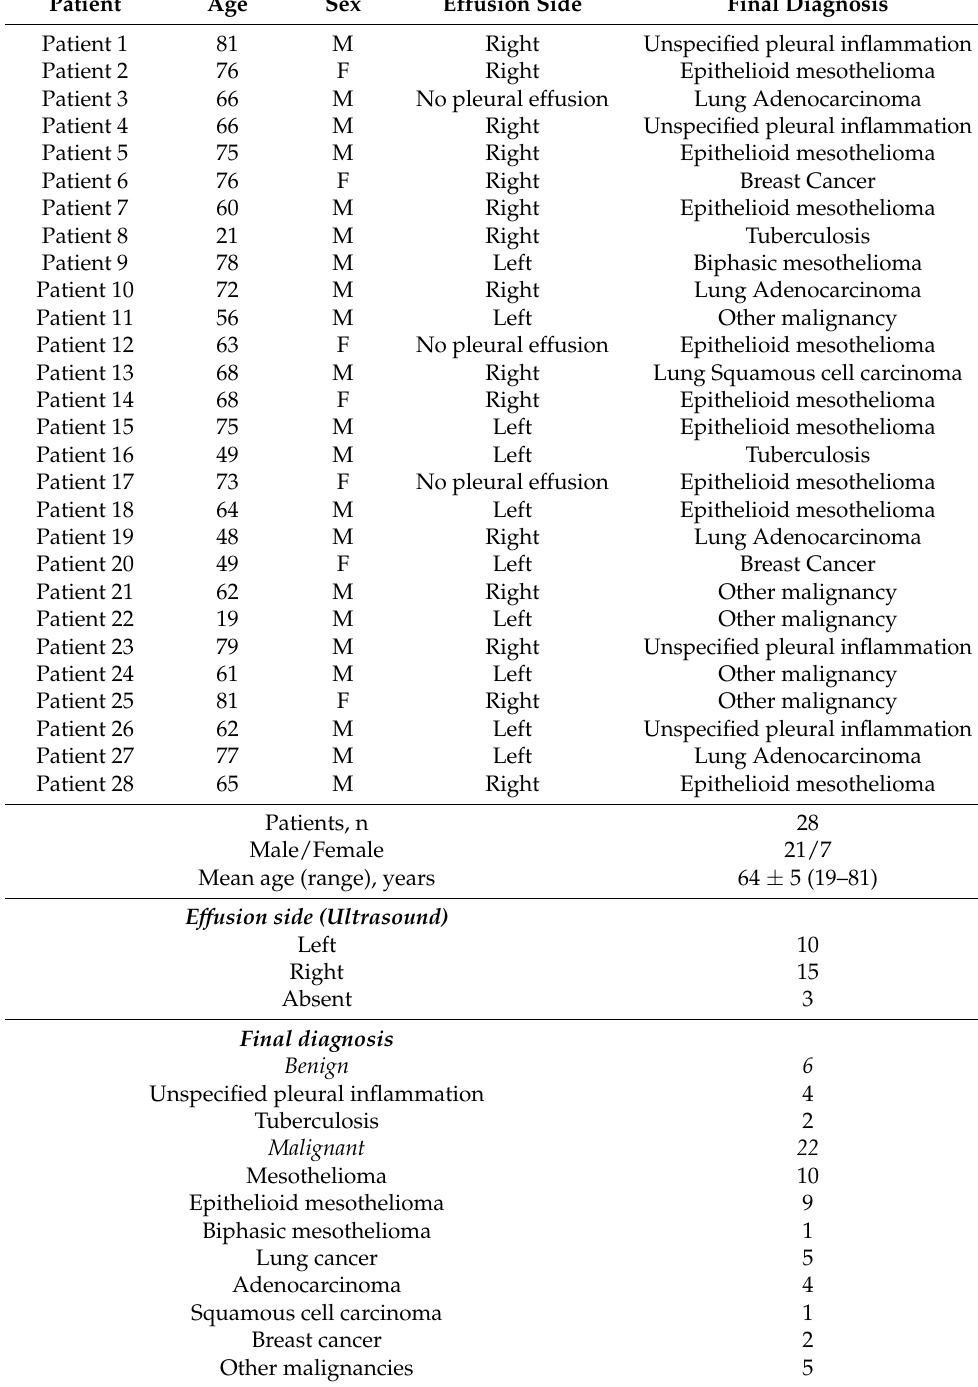
Table 1. Patients’